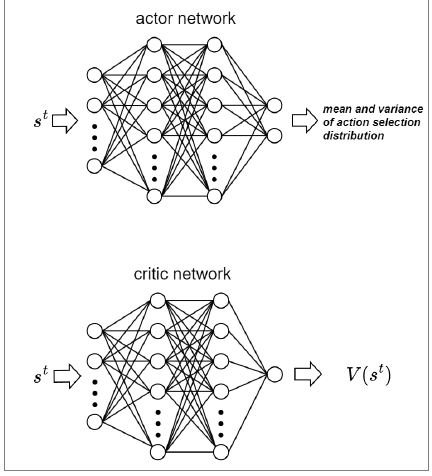
Figure 4. The actor and critic networks for the POPA.